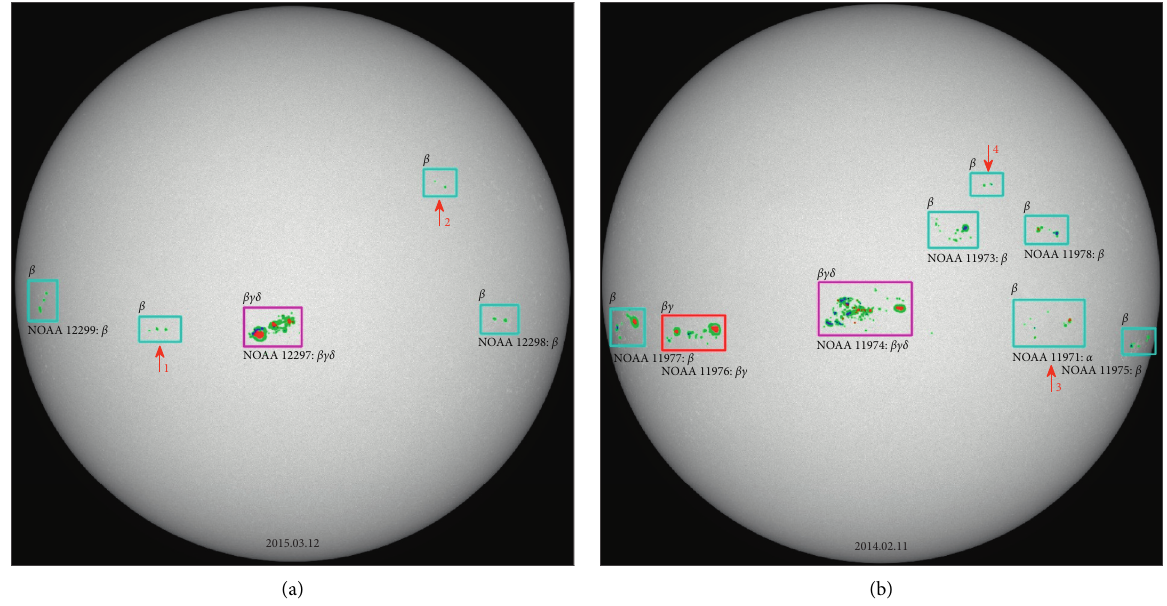
Figure 4: Two cases. The sunspot groups with solid-line boxes are detected by our method, where the classification results are displayed at the upper left of each box. The AR number and classification given by NOAA are manually labeled at the box below. The times of (a) and (b) are 20:00:00 UT on 12 March 2015 and 20:00:00 UT on 11 February 2014, respectively.